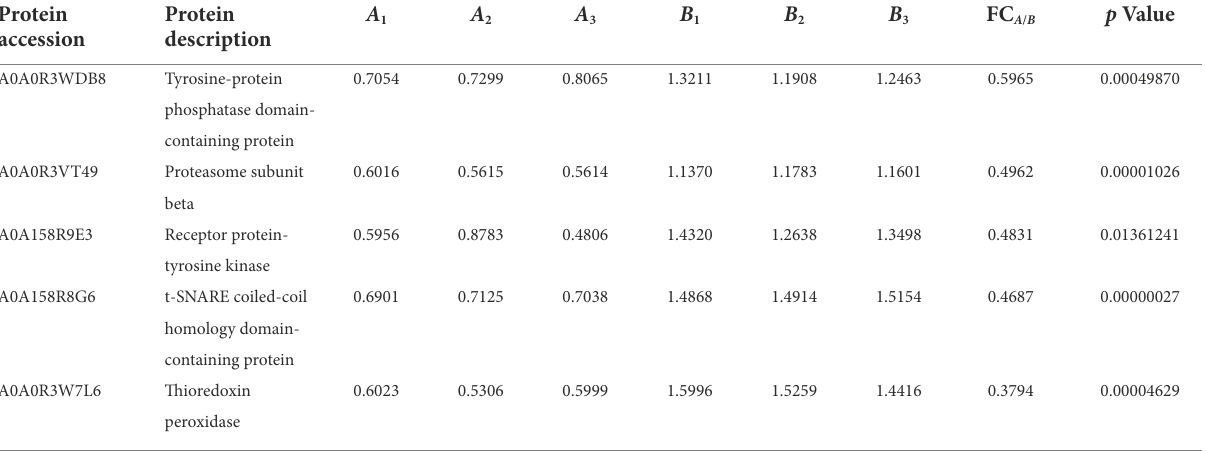
TABLE 1 Proteins with the function of regulating T-cell immune